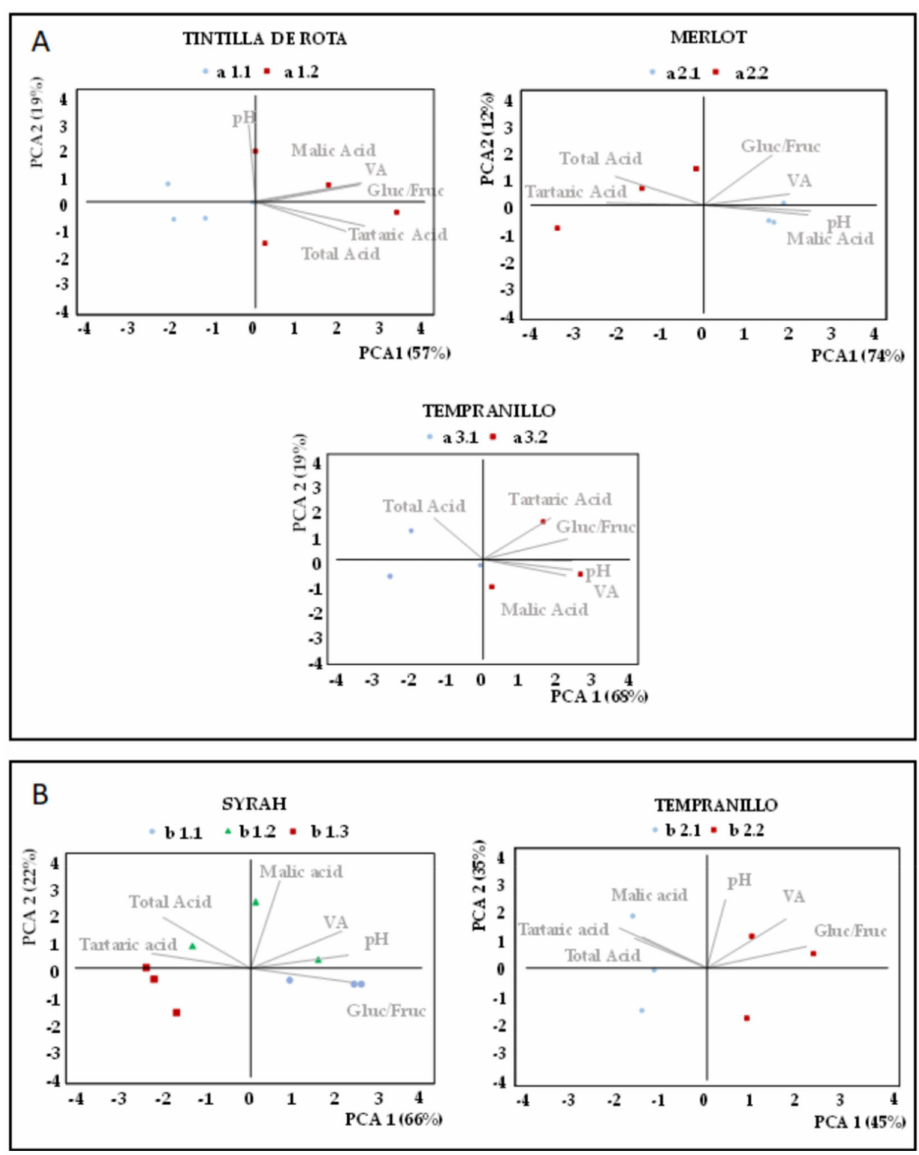
Figure 4. Principal Component Analysis (PCA) of the chemical composition in different grape varieties. ( A ) the use of elicitors and ( B ) canopy management